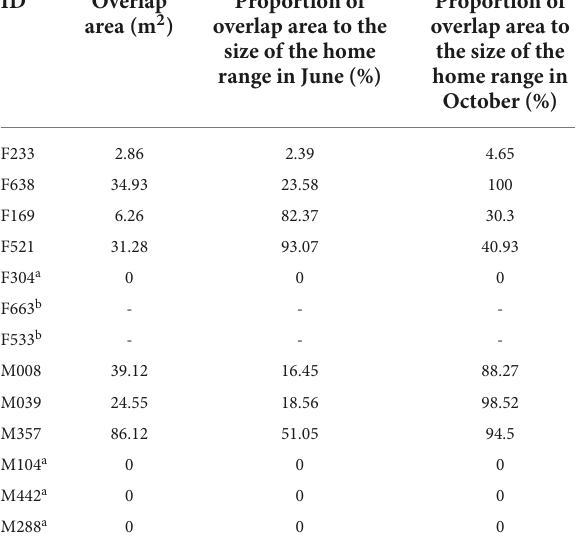
TABLE 3 Overlap area of the same individual’s home range between June and October and the percentage of the overlap ratio in each month of